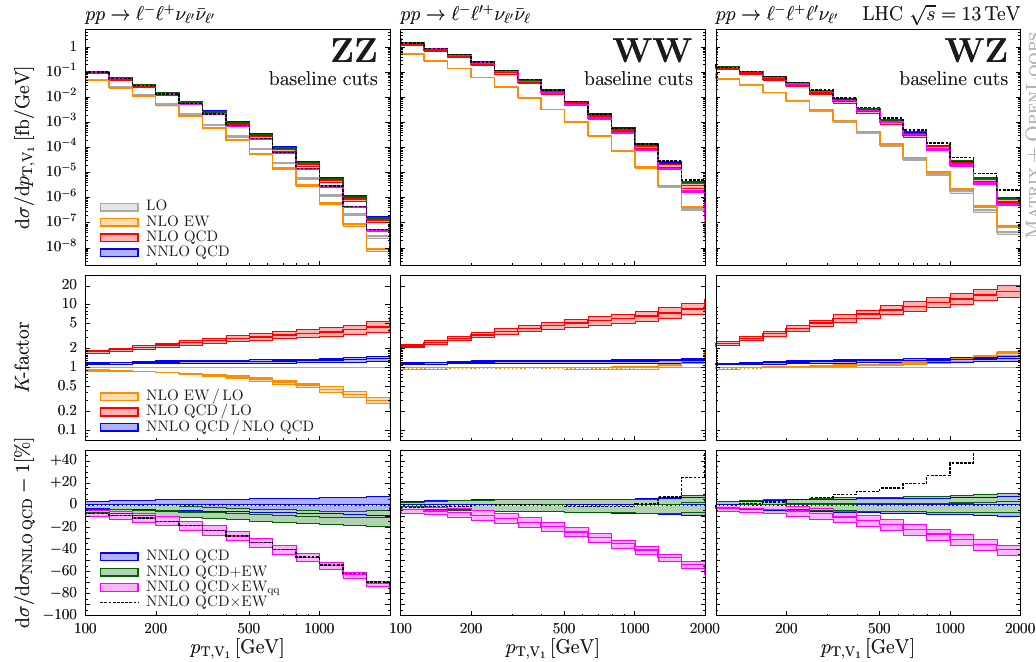
Figure 8 . Distribution in the transverse momentum of the harder reconstructed vector boson for the processes (3.1){(3.3) at 13 TeV. Baseline cuts are applied without jet veto. Plot format and predictions as in (cid:12)gure 6.